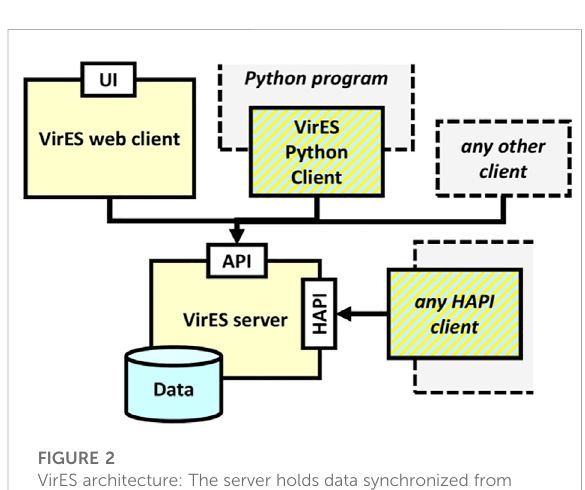
FIGURE 2 VirES architecture: The server holds data synchronized from external sources, which are accessible through the VirES API and the HAPI through a range of client